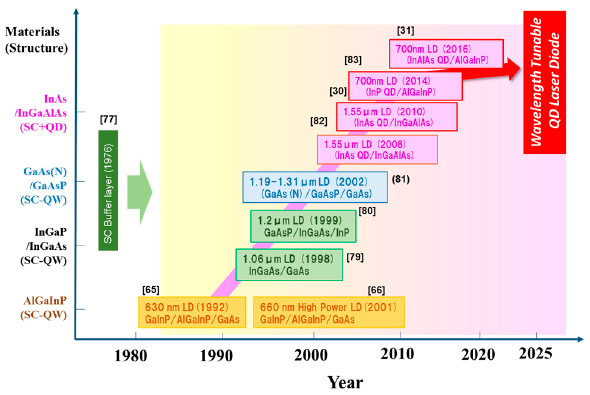
Figure 11. Development history of strain compensated quantum wells (QWs), quantum dots laser diodes, and their future prospects.